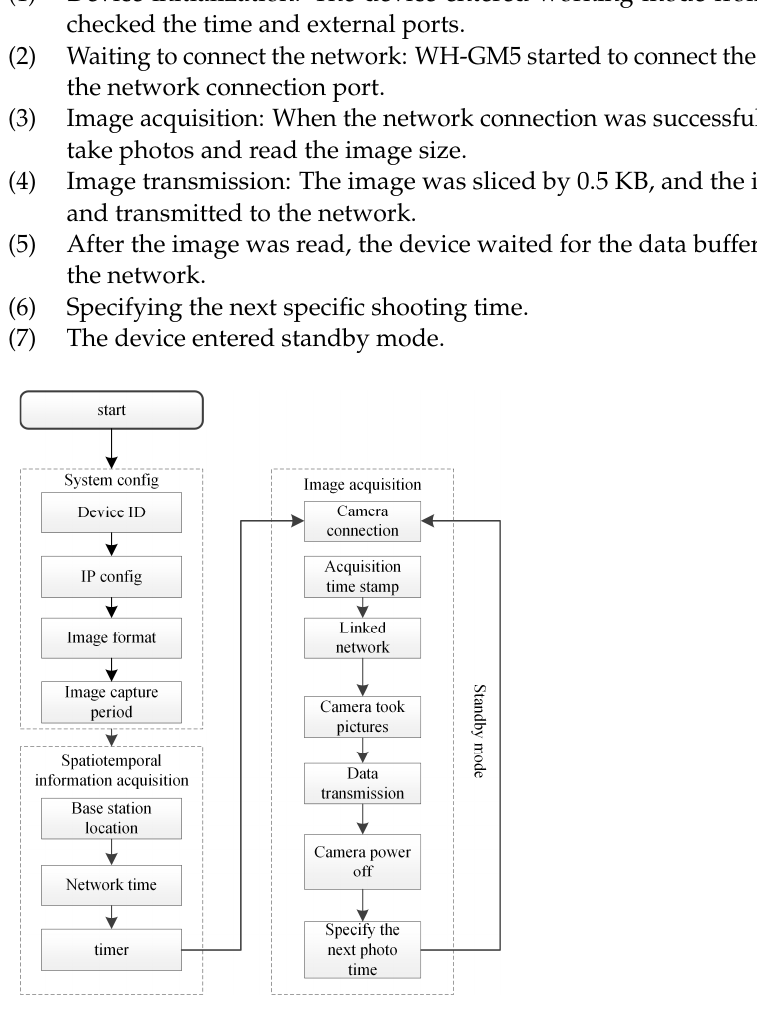
Figure 5. Flow diagram of the working principle.